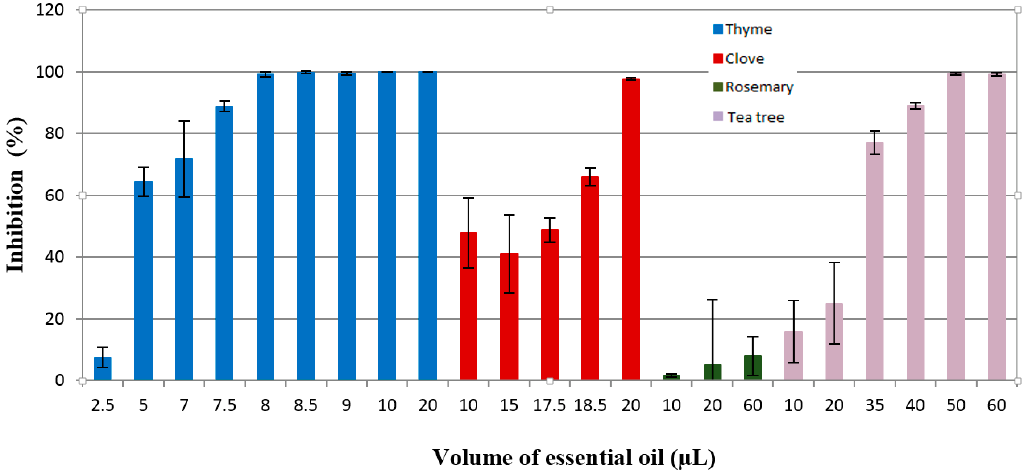
Figure 6. Inhibition of the Penicillium corylophilum CBMF1 growth by the thyme, clove, rosemary, and tea tree essential oils.